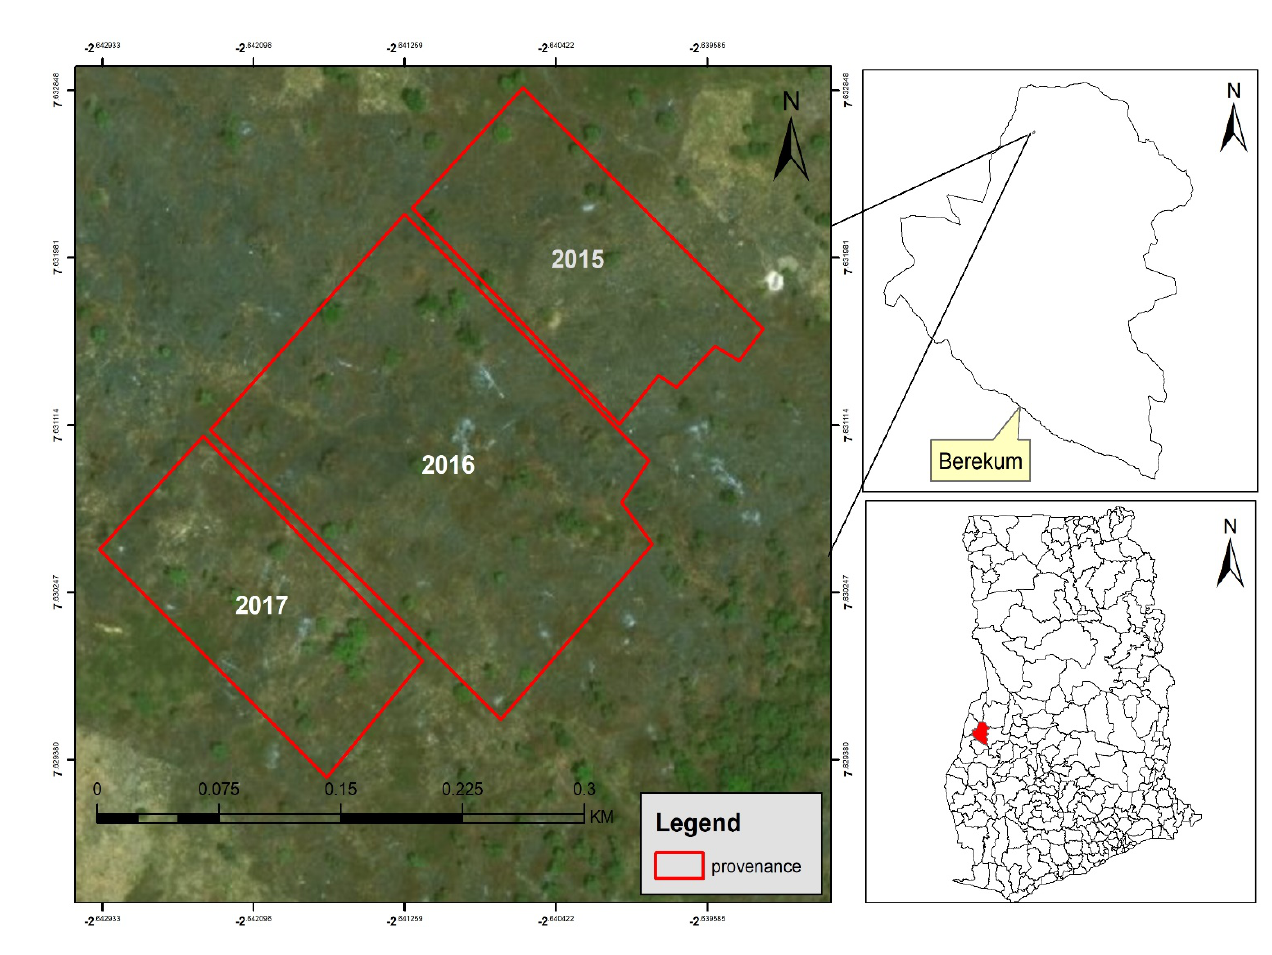
Figure 1. Map showing the location of the provenance trial in Ghana, and the various planting years sampled.